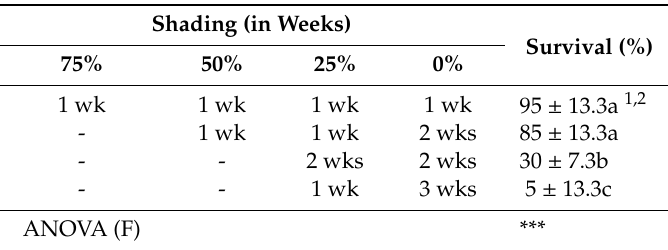
Table 6. Influence of shading treatments during acclimatization of in vitro-produced plantlets of Viburnum dentatum , derived from regenerant microshoots of encapsulated shoot tip explants which had stored at 4 ◦ C, on their survival rate (%). Shading (in